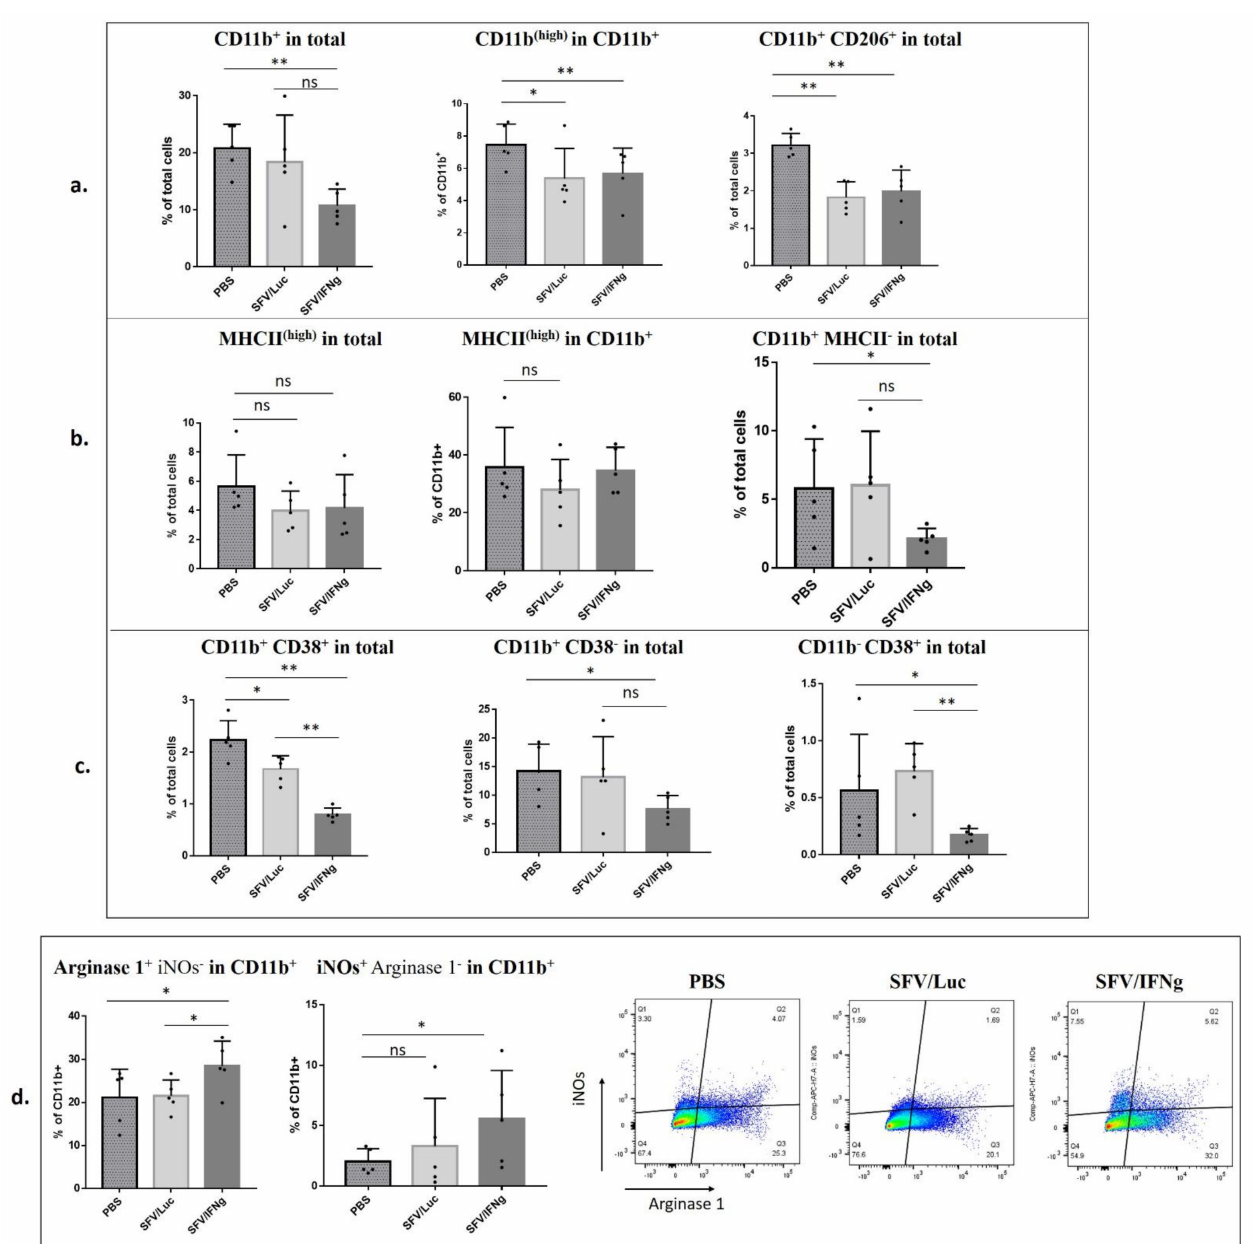
Figure 9. Flow cytometry analysis of myeloid cells in the tumors treated with SFV/IFNg, SFV/Luc, or PBS in an orthotopic 4T1 mouse breast cancer model. Mice were treated as shown in Figure 6d. Resected tumors were homogenized to obtain a single cell suspension, which was used for immunostaining with antibodies against surface markers (CD11b, CD206, MHCII, CD38) and intracellular markers (Arginase 1, iNOs) in one mixture. ( a ) Percentages of surface markers CD11b, CD11b (high), and double-positive CD206/CD11b. ( b ) Percentages of surface markers MHCII (high) and CD11b + MHCII − . ( c ) Percentages of surface markers CD11b + /CD38 + and CD11b − /CD38 + ( d ) Percentages of intracellular markers (Arginase 1; iNOs, inducible NO synthase); representative images of Arginase 1 and iNOs gating in the CD11b + population are shown. Bars represent the means ± SD ( n = 5); * p < 0.05; ** p < 0.01;